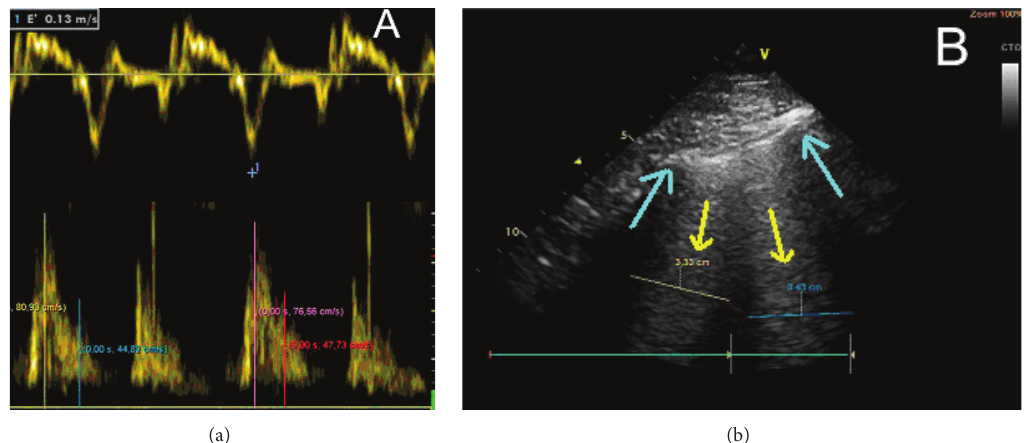
Figure 1: (a) Top: Doppler tissue of the lateral mitral annulus showing the value of 𝑒 󸀠 . Bottom: Doppler mitral filling. Together both images show a pattern of normal mitral filling estimate normal filling pressure (value 𝐸/𝑒 󸀠 < 8). (b) The picture shows lung ultrasound realized with a sectorial probe in the patient’s right chest, between fourth and fifth ribs in midclavicular line. Figure shows presence of vertical B lines > 3 mm (yellow arrows), indicative of pulmonary edema. Blue arrows show rib